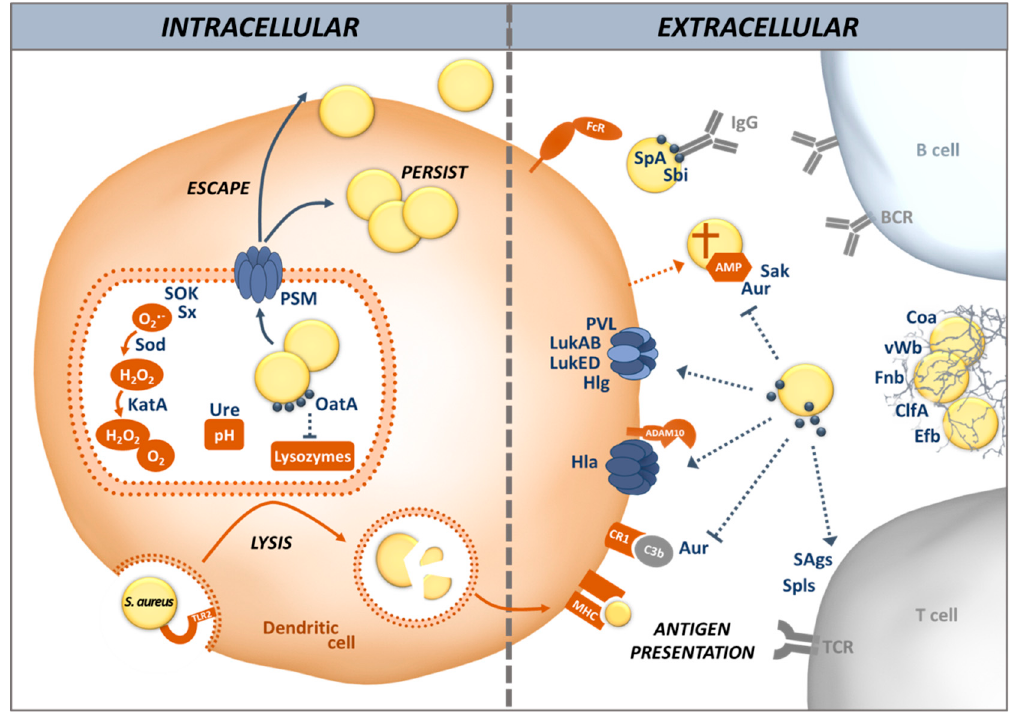
Figure 1. S. aureus ’ interaction with a dendritic cell during an infection. As antigen-presenting cells DCs are able to take up S. aureus , lyse the bacteria and present bacterial peptides on MHC class II to initiate a specific T cell response. However, S. aureus displays a broad range of mechanisms to avoid opsonization, phagocytosis and proteolytic degradation by DCs. In the extracellular space, S. aureus avoids opsonization by blocking antibody and complement function. SpA captures antibodies via their Fc region, thereby preventing recognition by Fc receptors. Aur cleaves complement factor C3 into non-functional C3b. ClfA, Efb and FnbAB bind to fibrinogen and fibronectin, respectively, facilitating the formation of a mesh that protects S. aureus from phagocytosis. The coagulases Coa and vWb potentiate this process by mediating the conversion of fibrinogen into fibrin. After engulfment by phagosomes, S. aureus can increase the local pH by producing Ure, preventing efficient lysis. OatA acetylates the peptidoglycan cell wall, rendering S. aureus resistant to lysozymes. The Sx and SOK have antioxidant properties, protecting S. aureus from membrane damage. In addition, S. aureus SodA, SodM and KatA can act in cascade to detoxify ROS. PSMs enable S. aureus to escape from the phagosomes, thus invading the cytoplasm and possibly killing the host cell, which releases S. aureus into the extracellular space. AMPs secreted by DCs can be degraded by Aur and Sak, protecting S. aureus from being killed. Furthermore, S. aureus produces several pore-forming toxins, among them Hla and the bi-component toxins LukAB, LukED, PVL and Hlg, that can directly kill DCs. Finally, S. aureus SAgs and Spls are able to modulate the balance of the initiated T cell response towards a more favorable Th2 profile. Brown: DC factors; blue: S. aureus factors.